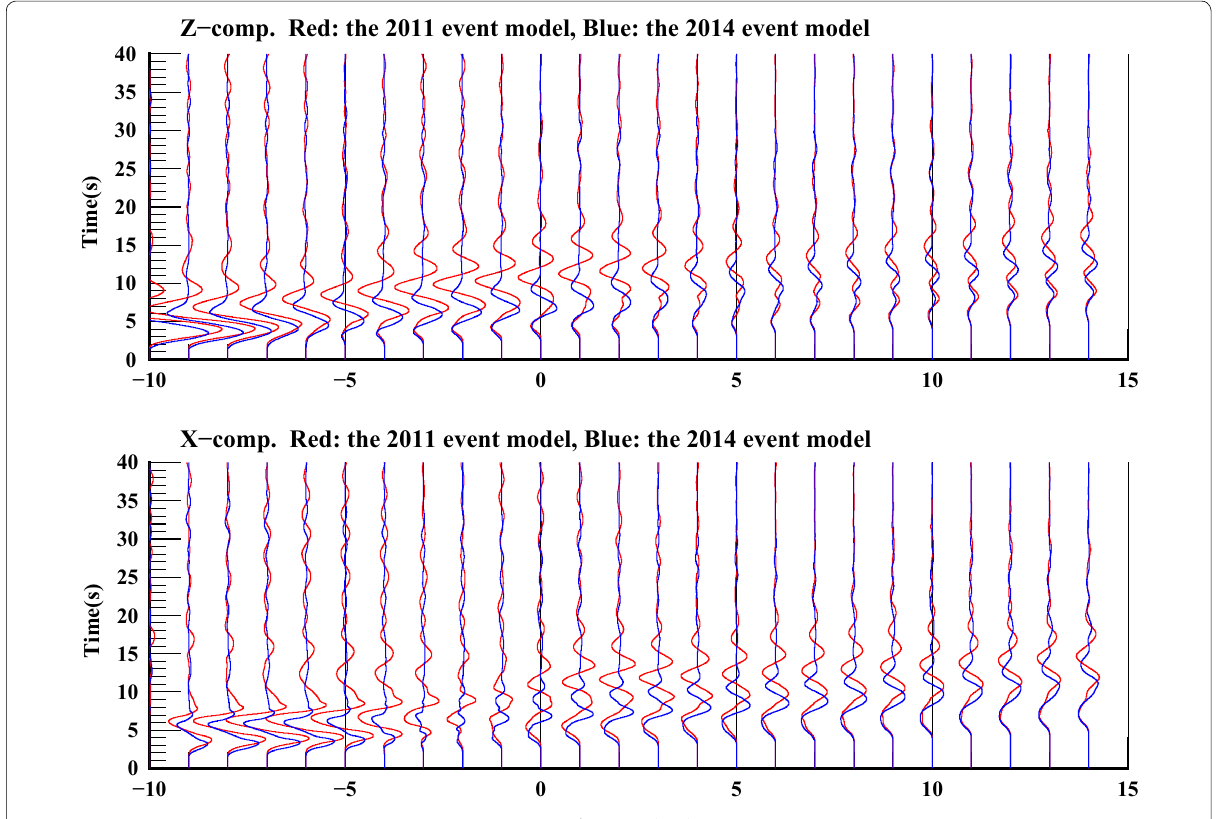
Fig. 10 Comparison of ground motion traces using different velocity structures in the source regions. Red and blue lines , respectively, show the ground motion traces using the 2014 and 2011 event models shown in Fig.